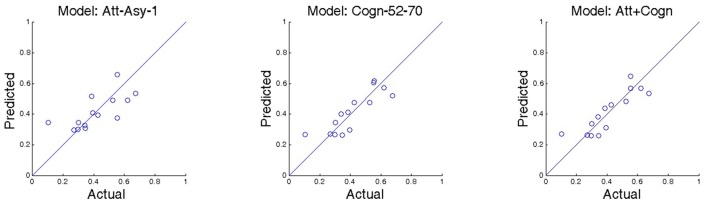
Shows scatter plots of actual vs. predicted sales performance KPI on the premiere of the movie for three different prediction models. The model abbreviations are as follows: Att-Asy-1: Attentional-asynchrony metric during the first viewing is used as the independent variable; Cogn-52-70: Cognitive-congruency metric calculated in the frequency range between 52 Hz and 70 Hz is used as the predictor variable; Att+Cogn: The combined predictor model where both the Cognitive-congruency metric (estimated on the frequency range 52–70 Hz) and the Attentional-asynchrony metric (calculated on measurements from the first viewing) are used as predictor variables.